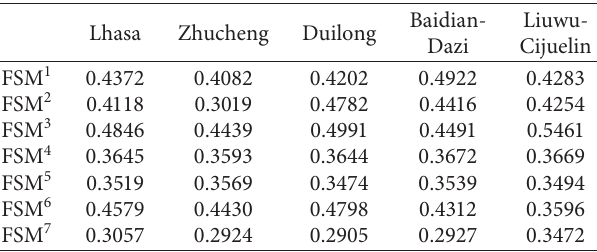
Table 3: Mean deprivation of travel in a single